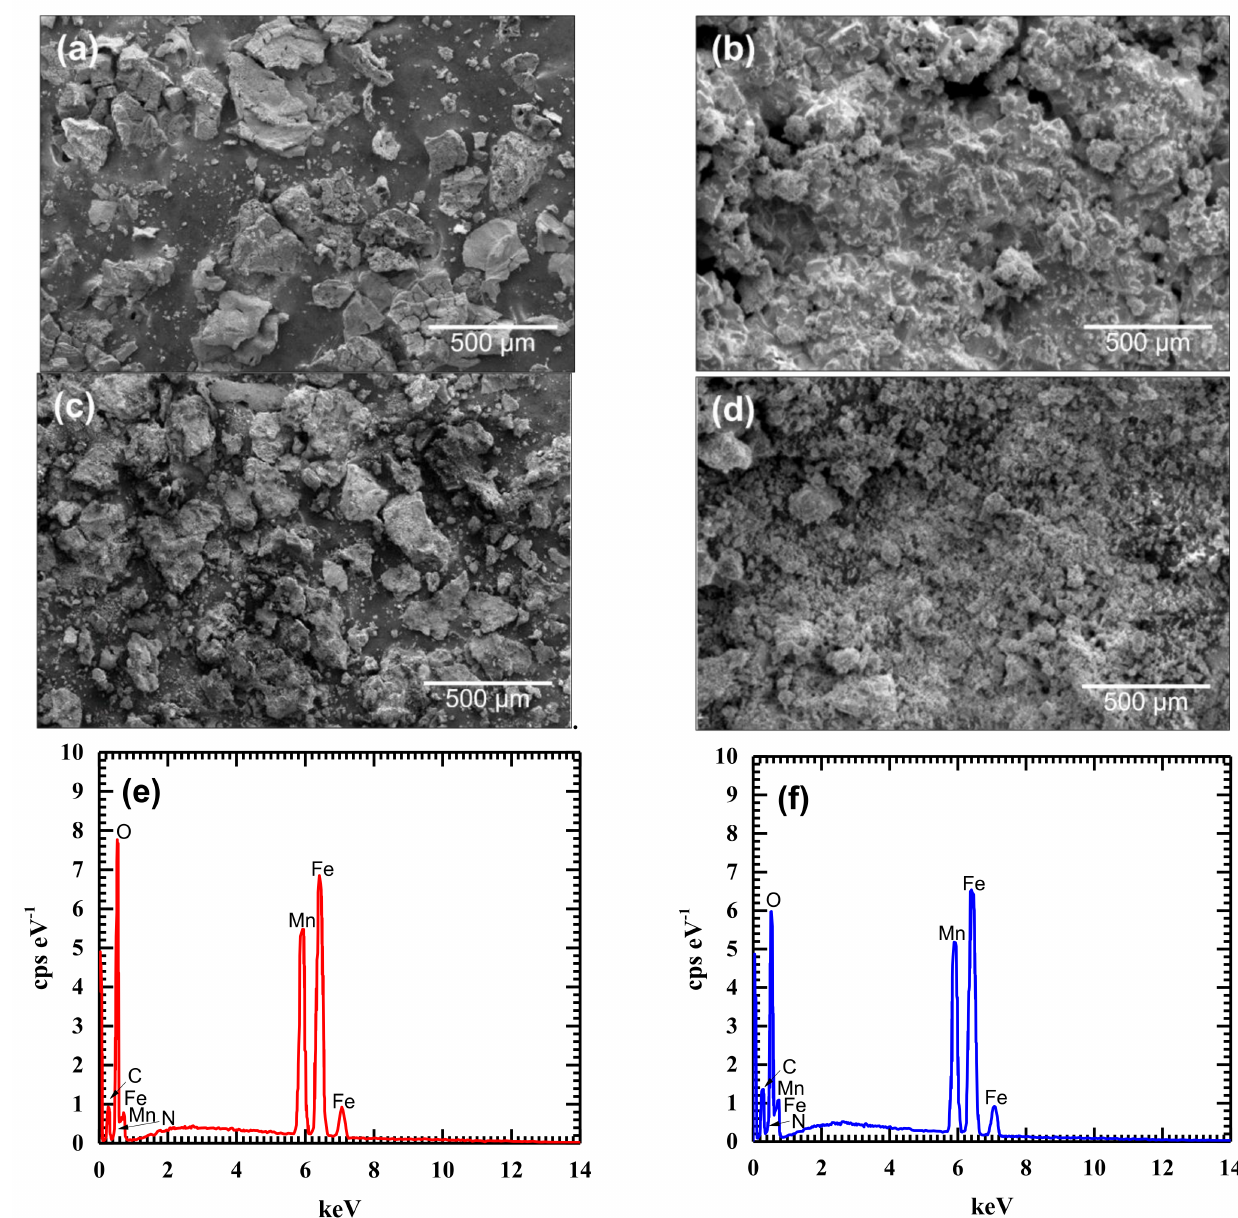
Figure 1. SEM images of ( a ) MFO taken at 100 × ; ( b ) MFO taken at 10,000 × ; ( c ) CMFO taken at 100 × ; and ( d ) CMFO taken at 10,000 × magnifications; EDS spectra of ( e ) MFO and ( f )